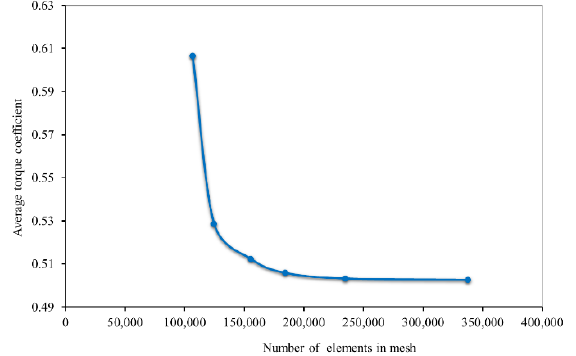
Figure 3. Mesh independence.